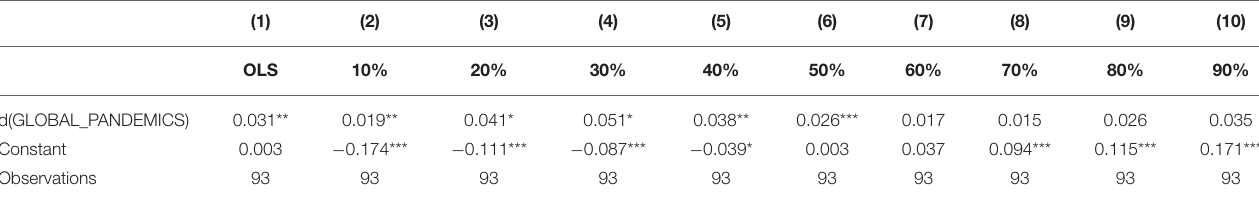
TABLE 4 | Results of the OLS and the quantile regression estimations of global art returns